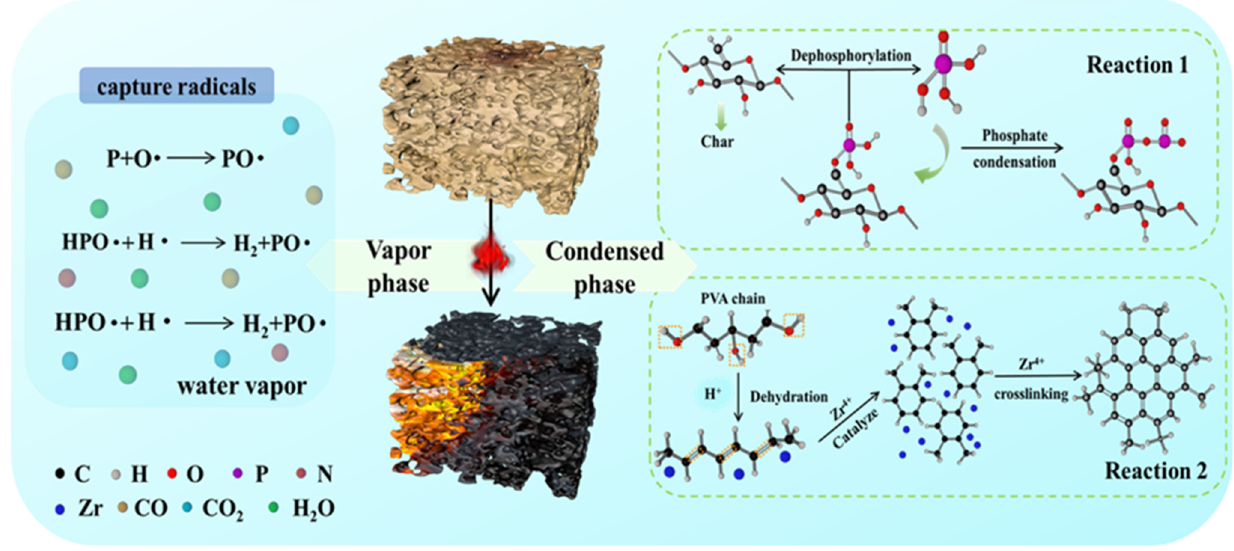
Figure 15. Mechanism of flame-retardancy of PVA/PCF 10 / α -ZrP 10 -3.